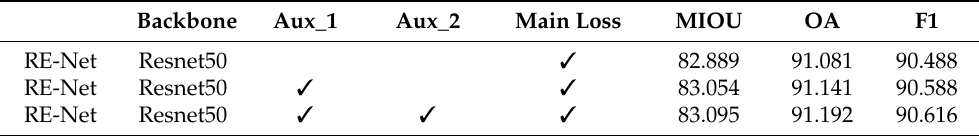
Table 1. Ablation study for multiple loss